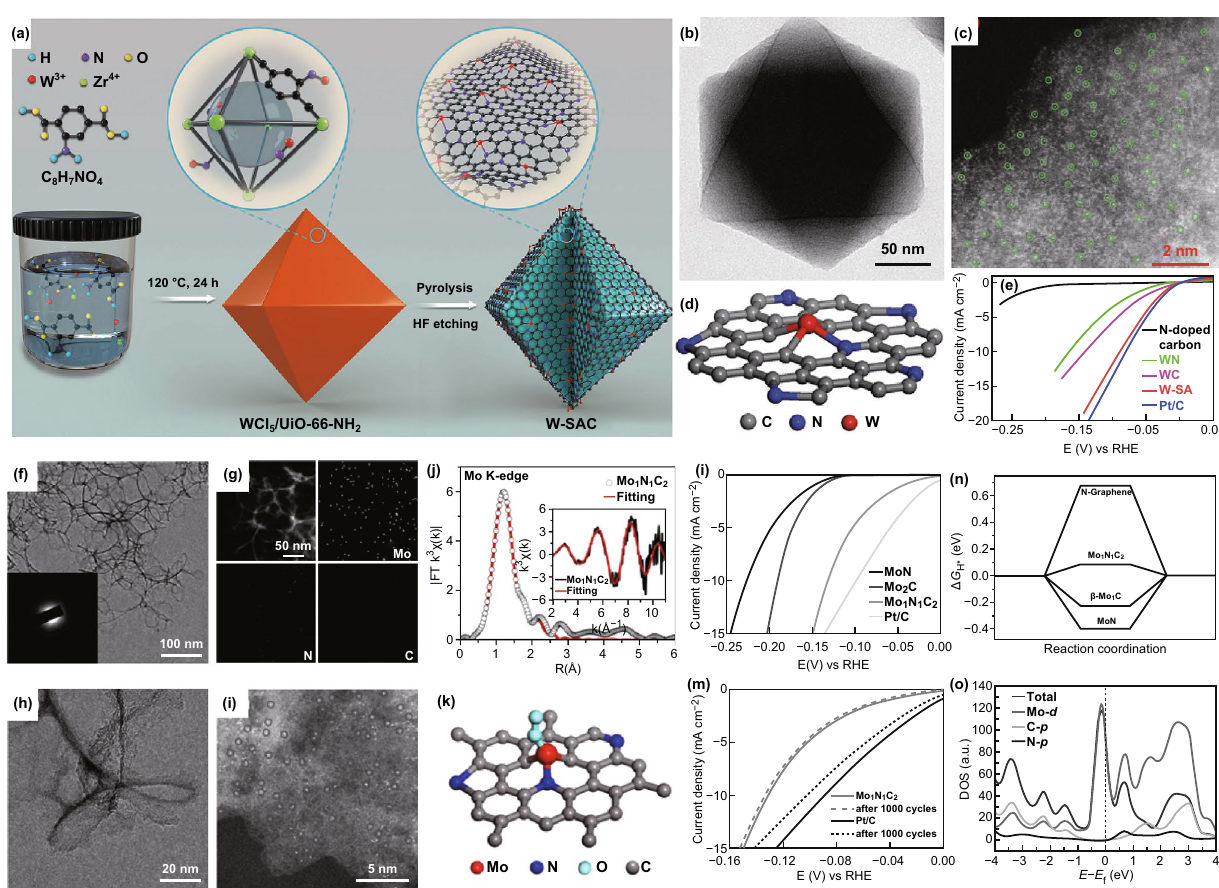
Fig. 16 a The formation process of W SACs. b TEM and c AC-HAADF-STEM images of the W SACs. d Atomic structure model of the W SACs. e Polarization curves for the W SACs. f TEM image of the Mo 1 N 1 C 2 , the insert is SAED pattern. g EDS maps for Mo 1 N 1 C 2 material. h HRTEM and i AC-HAADF-STEM images of the Mo 1 N 1 C 2 . j Mo K-edge FT-EXAFS fitting curves of the Mo 1 N 1 C 2 . k Atomic structure model of the Mo 1 N 1 C 2 . l Polarization curves for the Mo 1 N 1 C 2 , MoN, Mo 2 C, and 20% Pt/C. m Polarization curves for the Mo 1 N 1 C 2 before and after 1000 CV cycles. n Gibbs free energy for H * adsorption for Mo 2 C, Mo 1 N 1 C 2 , and MoN. o The calculated DOS of the Mo 1 N 1 C 2 . Panels are reproduced from Refs. [148, 153] with permission. Copyright 2018 and 2017